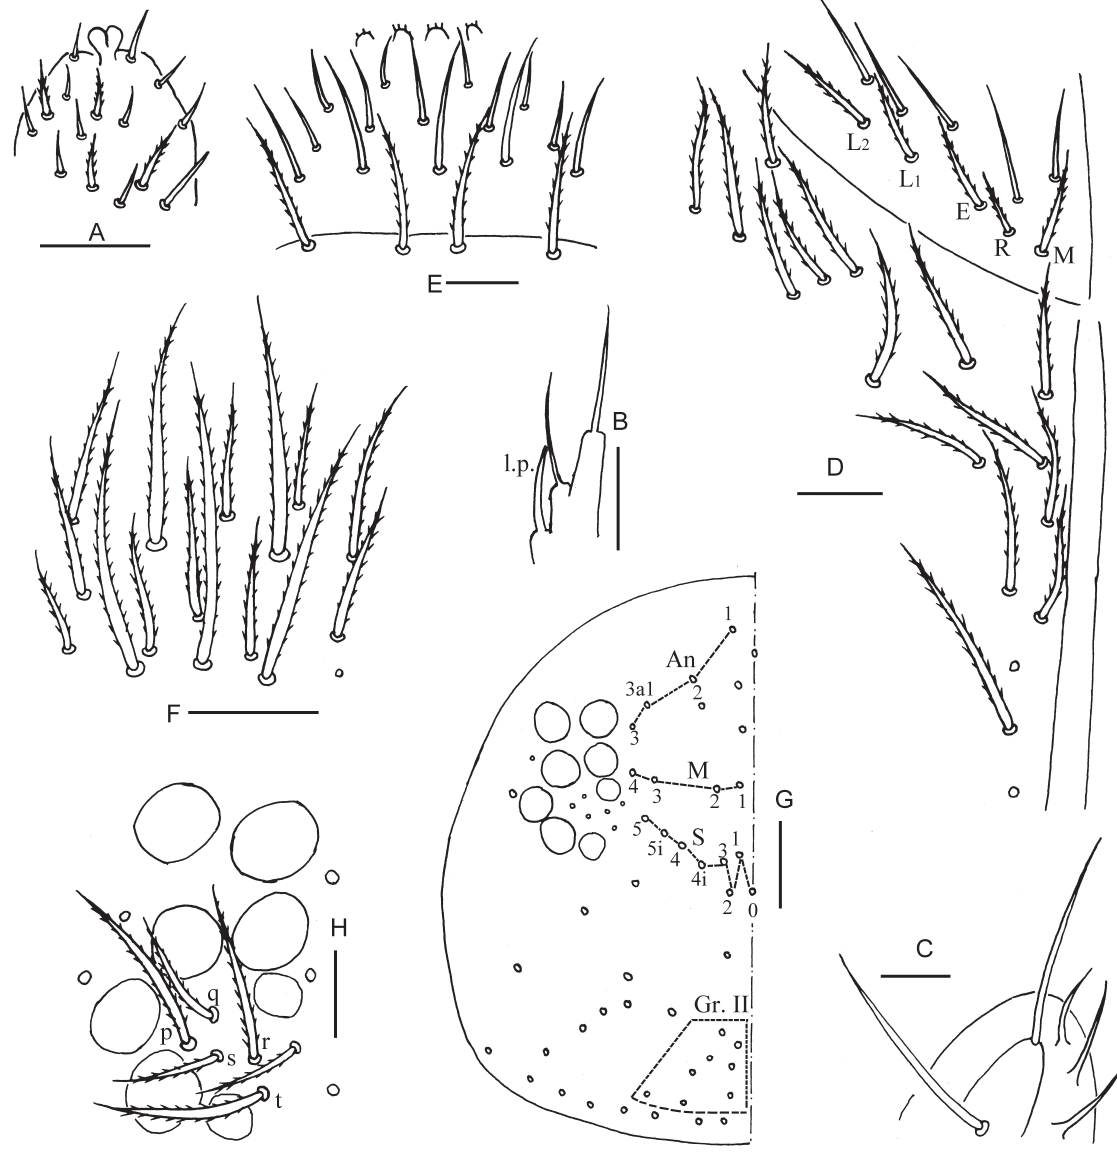
Fig. 12. Entomobrya dingi sp. nov. A . Apex of Ant. IV. B . Lateral process of labial palp. C . Maxillary outer lobe. D . Labium. E . Labrum. F . Clypeal chaetae. G . Dorsal chaetotaxy of head. H . Eyes and interocular chaetotaxy. Scale bars: A–C, E–F, H= 20 μm; D, G = 50